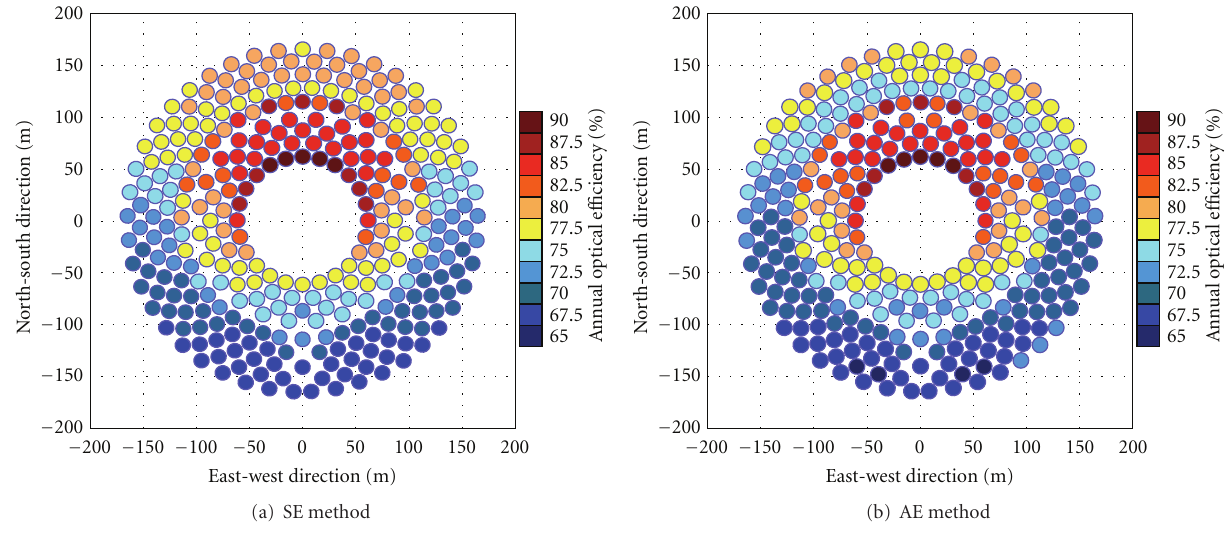
Figure 8: The annual optical e ffi ciency of heliostat in the case of latitude 30 ◦